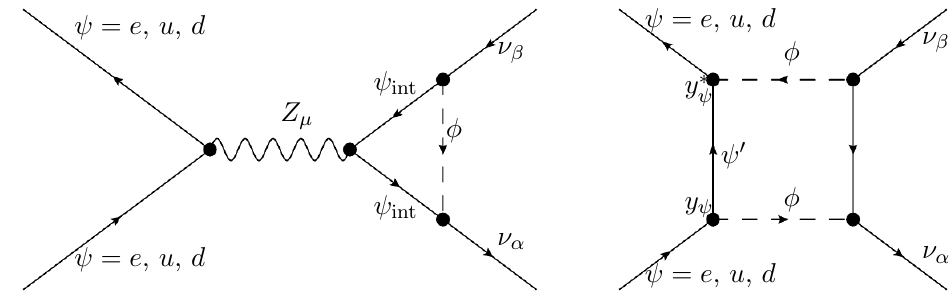
Figure 1 . Triangle and box diagrams which generate the NSI in eq. (2.18).